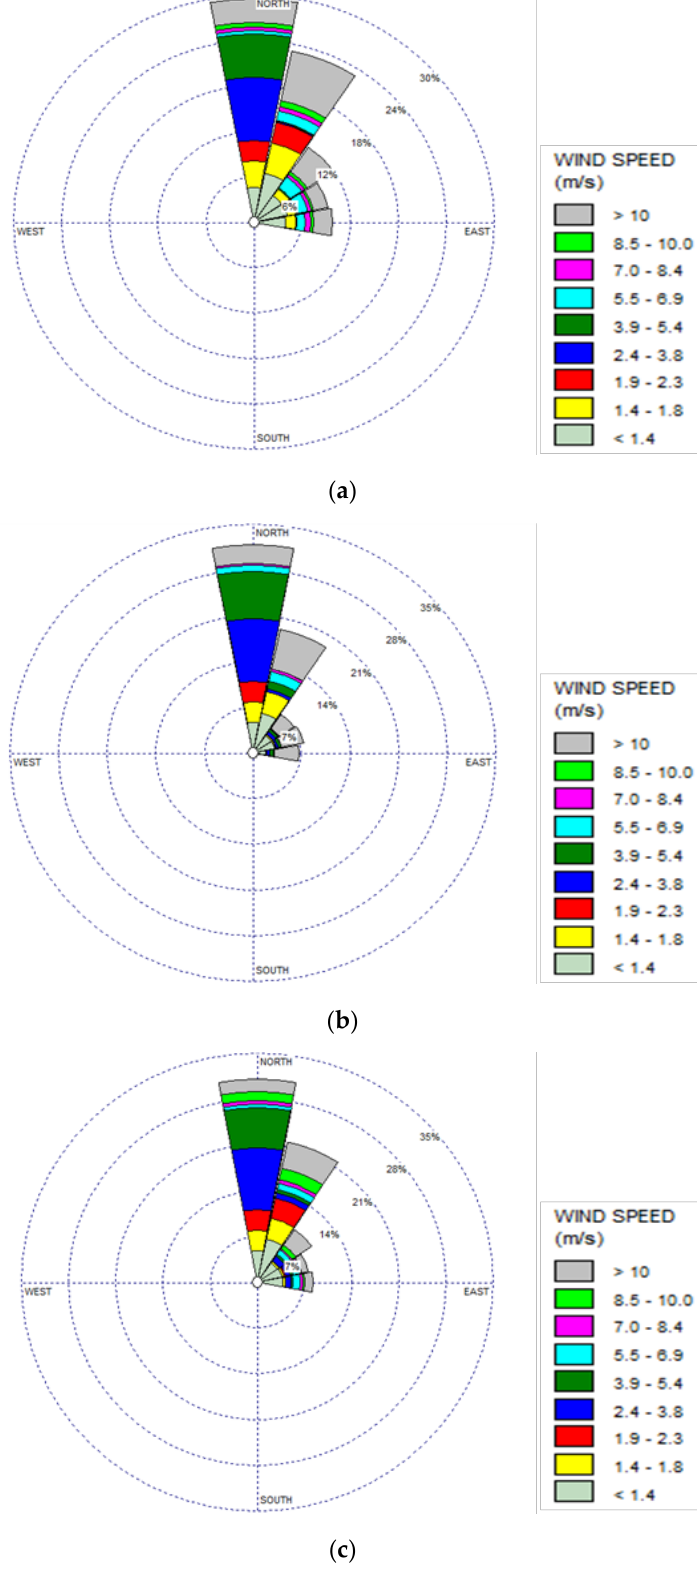
Figure 5. Wind rose of the studied sites. ( a ) Mersing; ( b ) Kudat; and ( c ) Kuala Terengganu.